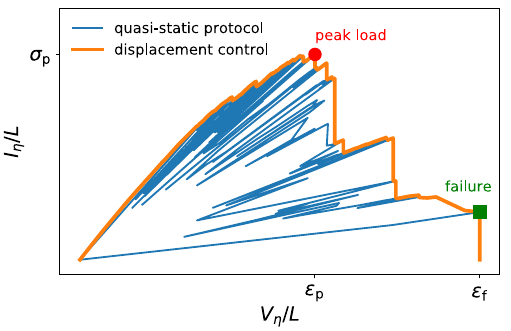
Figure 2. Example of I − V characteristic. Thin blue line: data from the quasi-static simulation protocol. Thick orange line: displacement-control envelope, representing the dependence of the global stress σ on the global strain ε in the case in which the voltage difference between the top and bottom bus bars is increased monotonically. The peak stress σ p denotes the peak load that the system can carry, while the failure strain ε f stands for the maximum strain that is encountered in displacement control, before the system breaks. The interval between peak load and failure identifies the post-peak